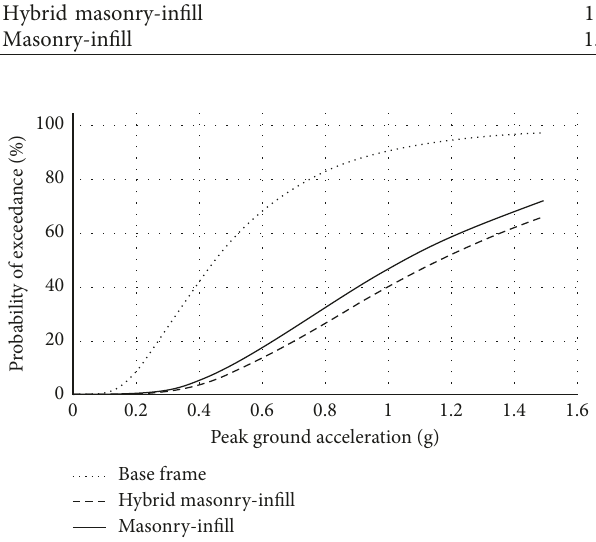
Figure 17: Seismic fragility functions derived for probabilistic assessment of test models. The functions are derived for a roof drift of